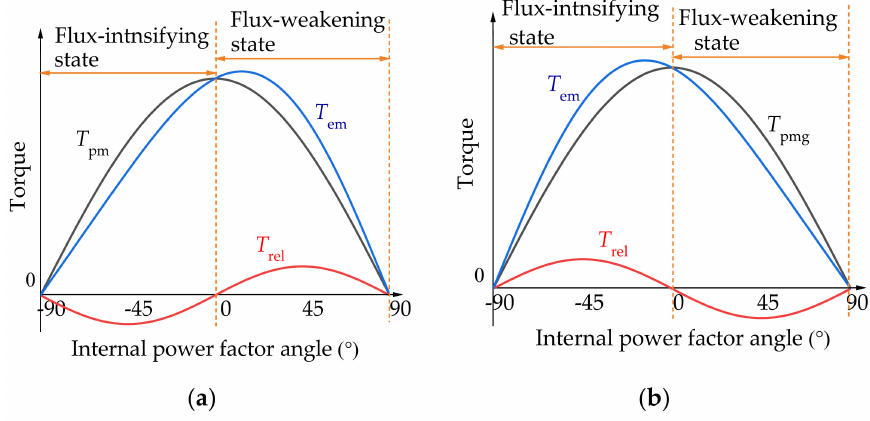
Figure 2. The torque curve of the PMSM, ( a ) conventional IPMSM; ( b ) RSPMSM.